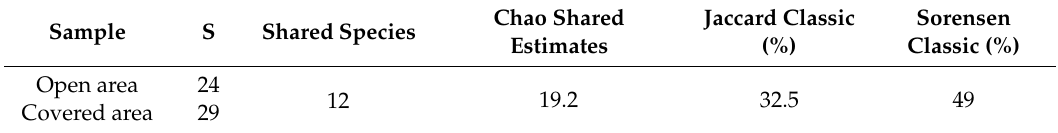
Table 6. Ant shared species (S* = total observed species for each habitat).